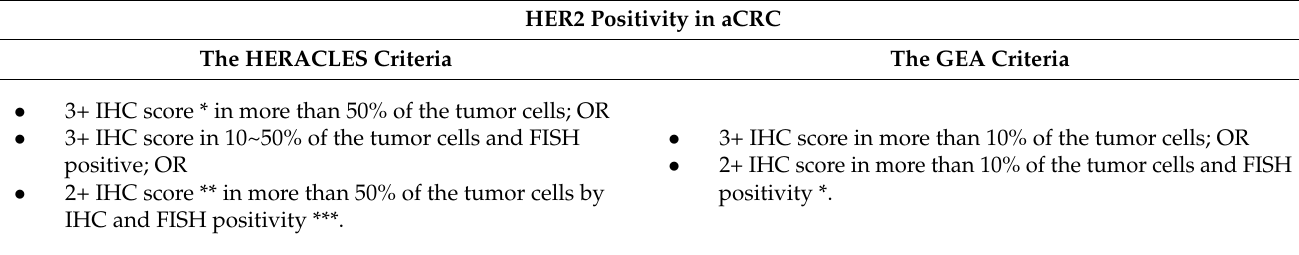
Table 1. The HER2-positivity definition in aCRC according two different system: the HERACLES criteria and the GEA criteria. HER2 Positivity in